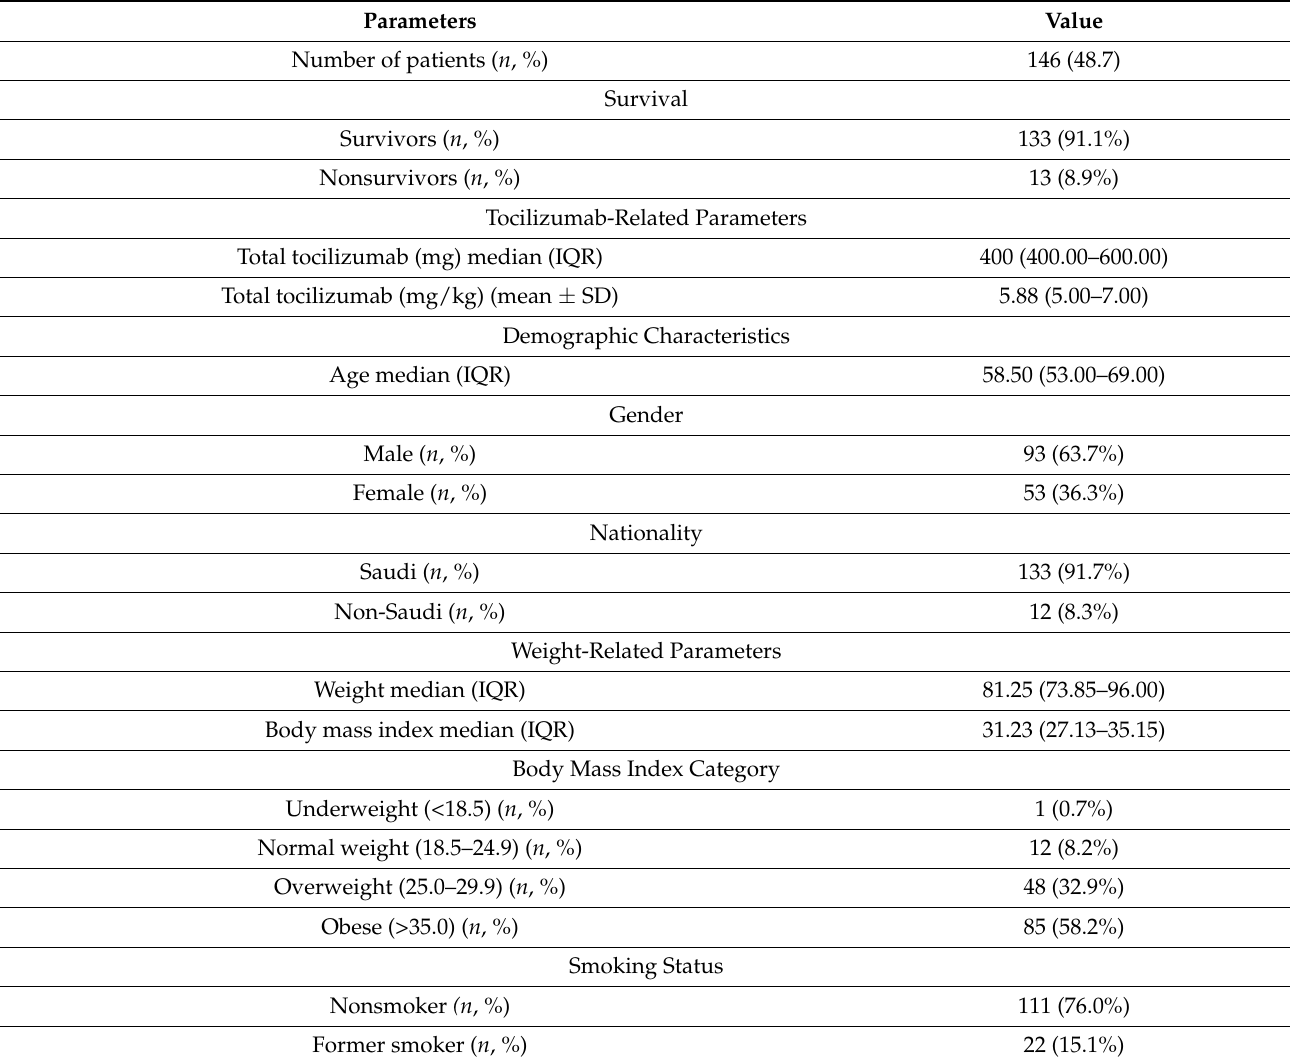
Table 2. Clinical and laboratory characteristics of COVID-19 patients who received single doses of tocilizumab—the most recent lab results before tocilizumab administration vs. the most recent lab results before discharge (all patients n =